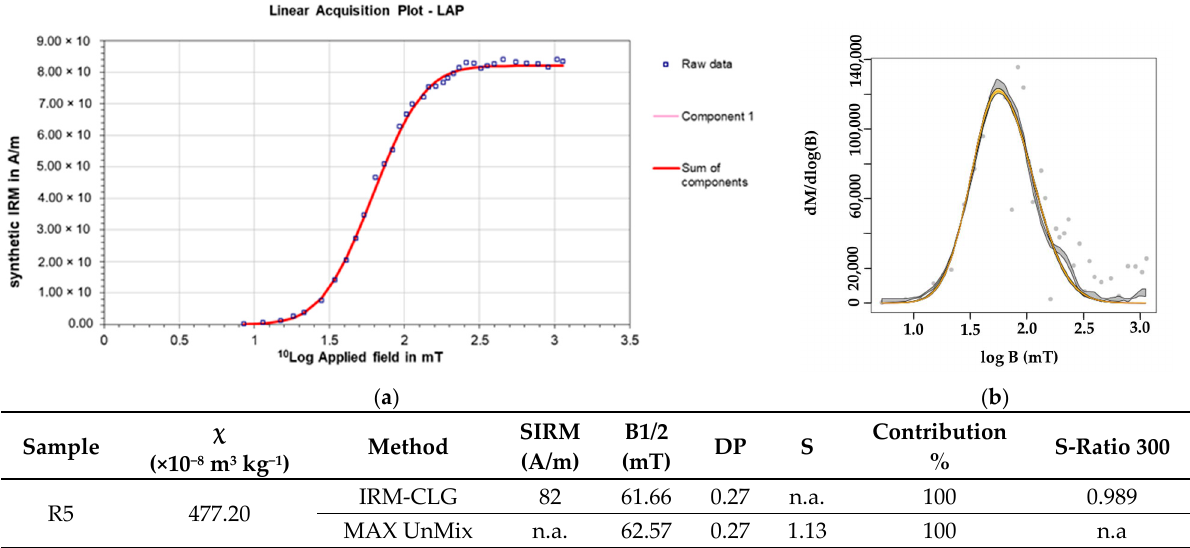
Figure 11. Schematic χ lf- χ fd% scattergram (adapted from [21]). SP—superparamagnetic grains; SSD—stable single-domain grains; MD—multidomain grains.